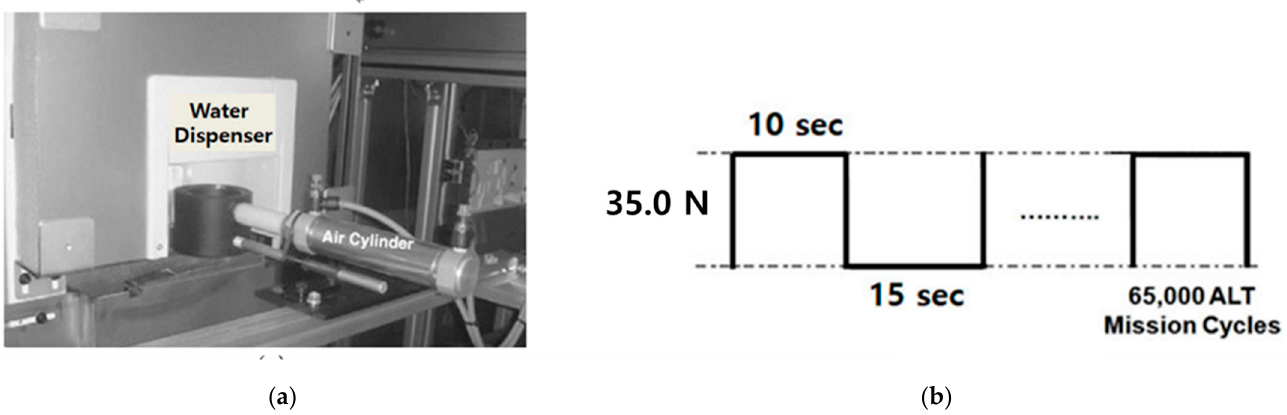
Figure 10. ALT apparatus with duty cycles. ( a ) Equipment and ( b ) duty cycles of repetitive impact load F.